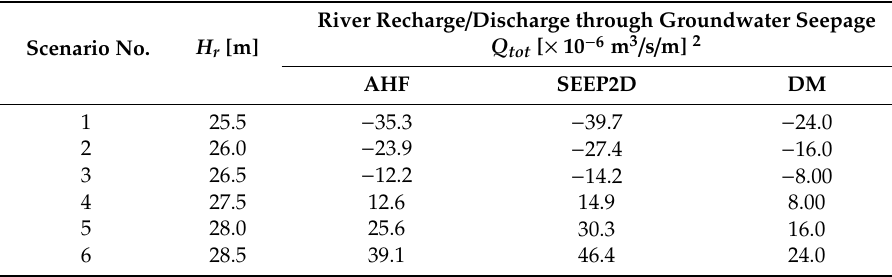
Figure 5. Specific discharge fields and hydraulic head distribution in the river–aquifer system calculated ∗ = for H r = 28.5 m and Φ 27.0 m with ( a ) AHF and ( b ) SEEP2D models (both with the assumption of no flow between subregions P.3–P.4 and P.1–P.3). Table 4. Calculated river recharge / discharge through groundwater seepage.